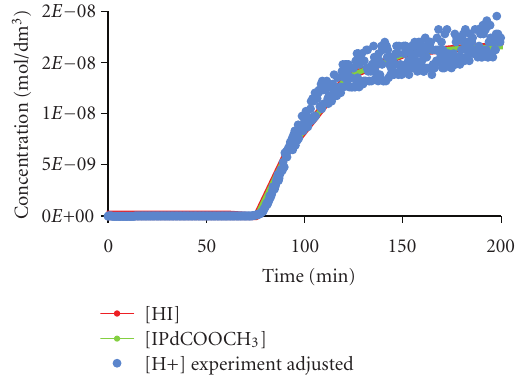
Figure 8: Fitted data using Model 3 against experimental data presented in Figure